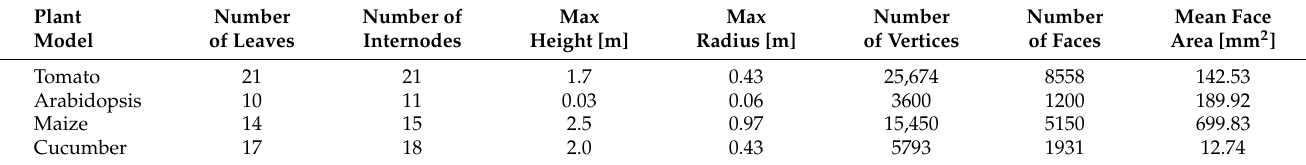
Table 1. Summary of the plant model properties. Starting from the number of geometric primitive objects of the original 3D model, i.e., number of leaves and internodes and morphological traits like plant dimensions, to the number of vertices and faces of the triangulated